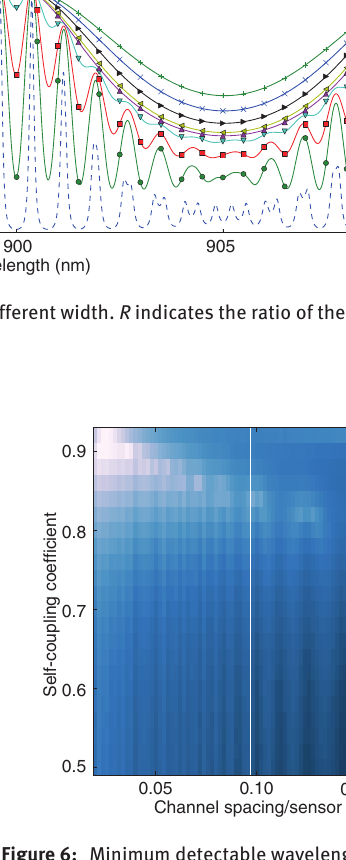
Figure 6: Minimum detectable wavelength shift on fitted wave- length for the Vernier as a function of ratio of filter channel width to sensor FSR and self-coupling